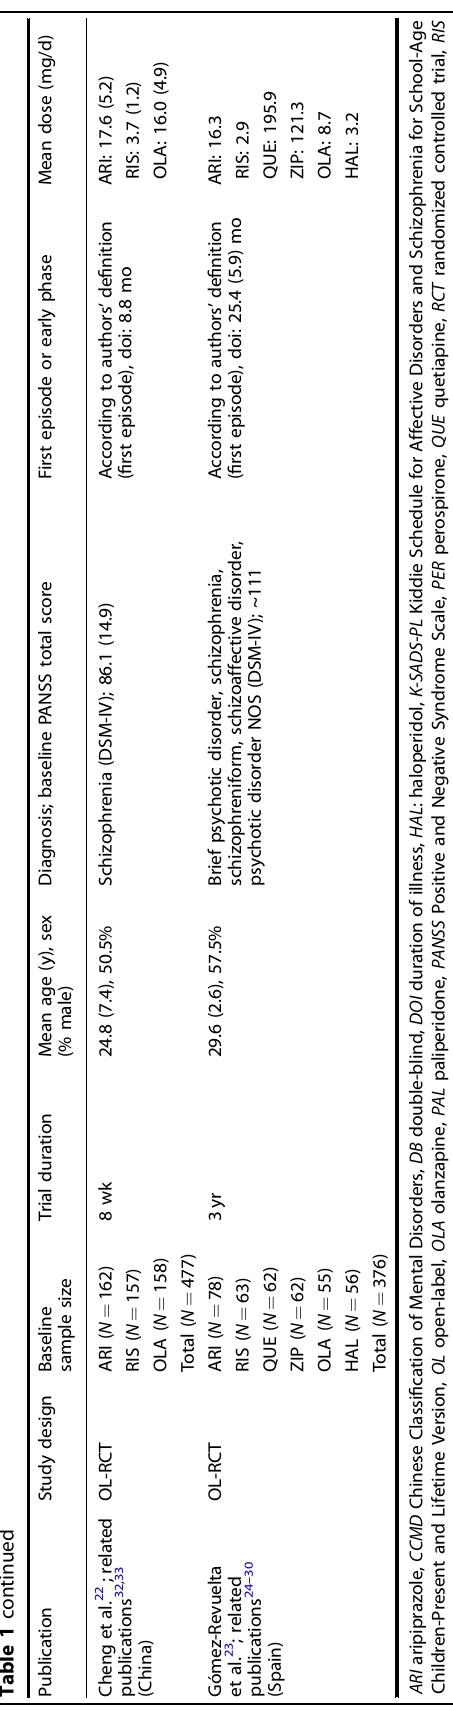
holinergics, weight gain, total cholesterol levels, and prolactin levels. Meta-regression In our meta-regression analysis, associations of covariates with overall symptom reduction ( n = 14 studies) and all-cause dis- continuation ( n = 11 studies) were examined (Supplementary Table 1). Aripiprazole ’ s effect on overall symptom reduction relative to D 2 R antagonists was positively associated with trial duration (estimate = − 0.01, p = 0.020) and baseline symptom severity (estimate = − 0.02, p = 0.041). None of the covariates demonstrated signi fi cant associations with all-cause